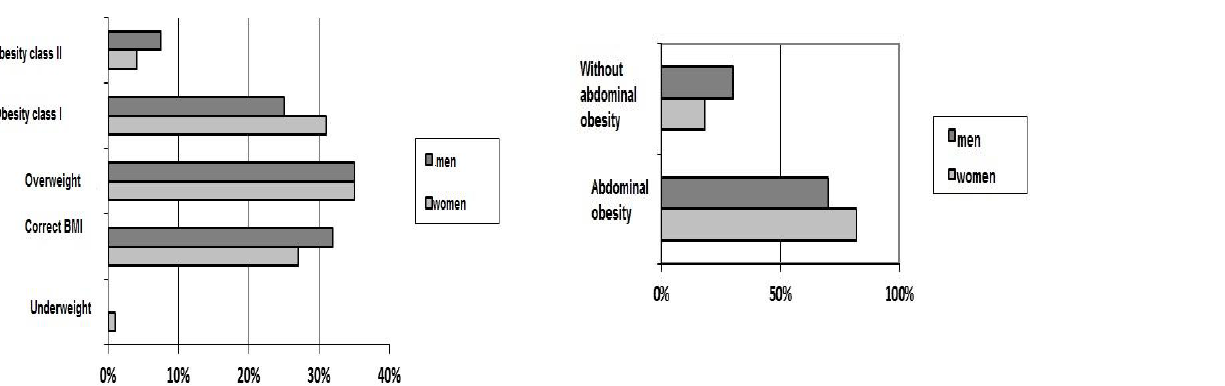
ured in percentages.